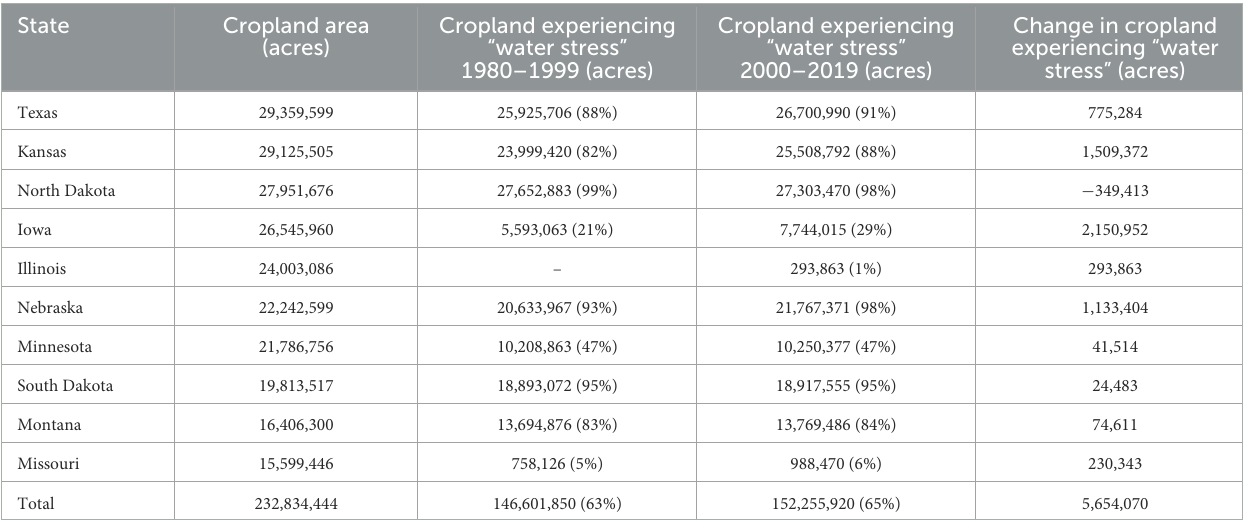
TABLE 5 Summary of results from combinatory metrics considering: (1) cropland area (acres); (2) area of cropland experiencing “water stress” (acres) for the 1980–1999 period (i.e., left panels in Figure 7); and (3) area of cropland under water stress (acres) for the 2000–2019 period (i.e., right panels in Figure 7).